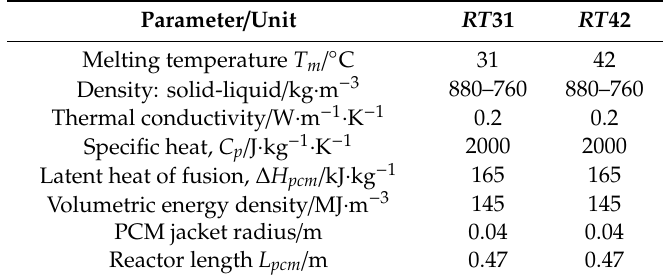
Table 2. Thermo-physical properties of Rubitherm-based phase change materials